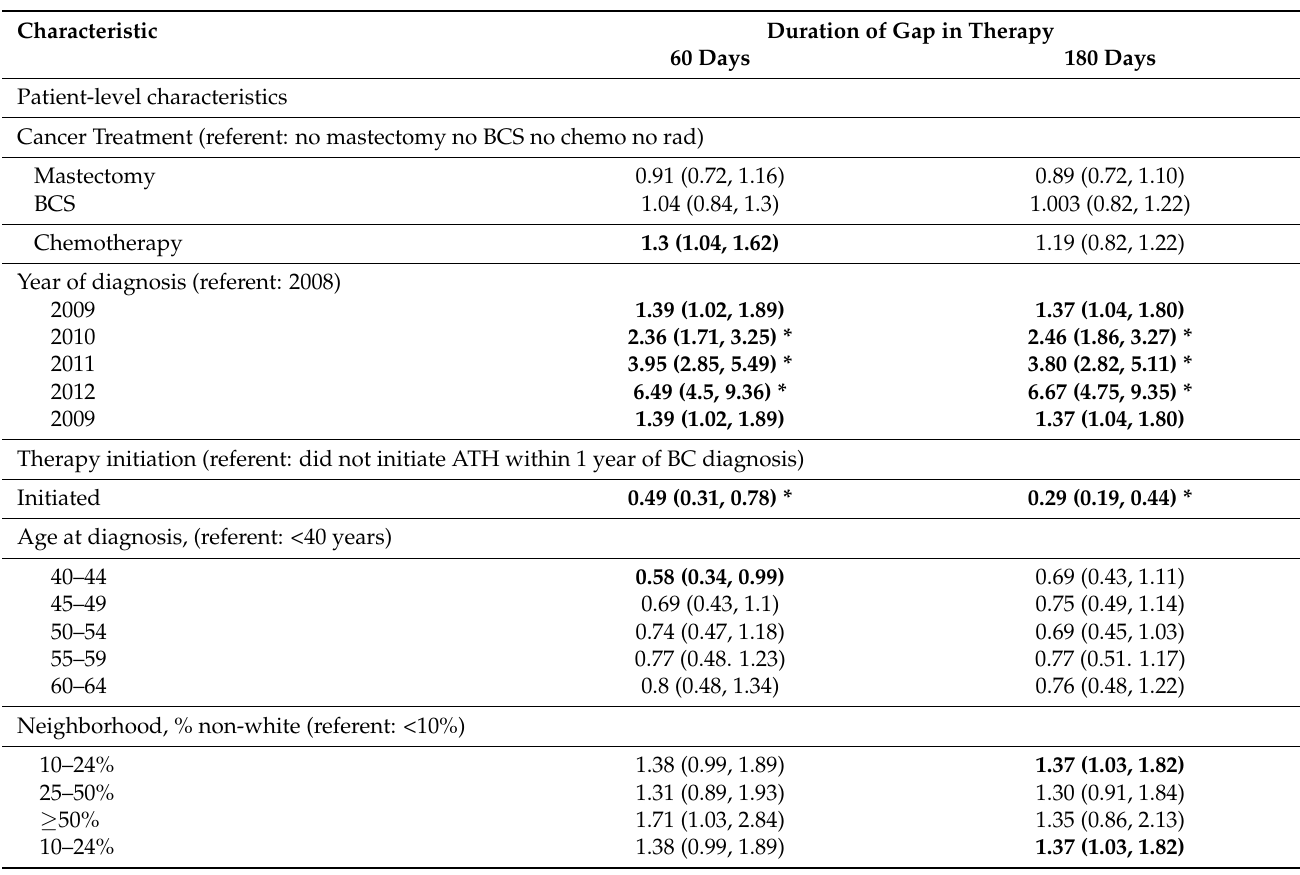
Table A3. Predictors of failure to continue with adjuvant hormonal therapy by length of the